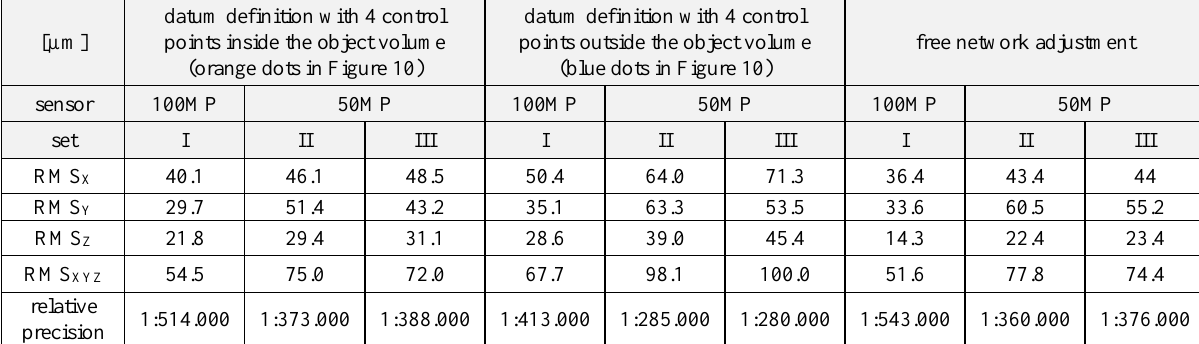
Table 5. Results of object point precision (1σ RMS) in large volume application for the ALPA 12 FPS add|metric in microns